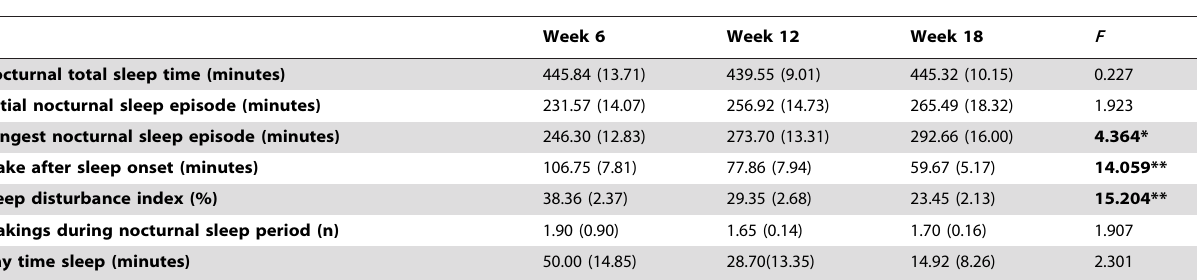
Table 1. Change in postpartum maternal sleep and sleep disturbance.